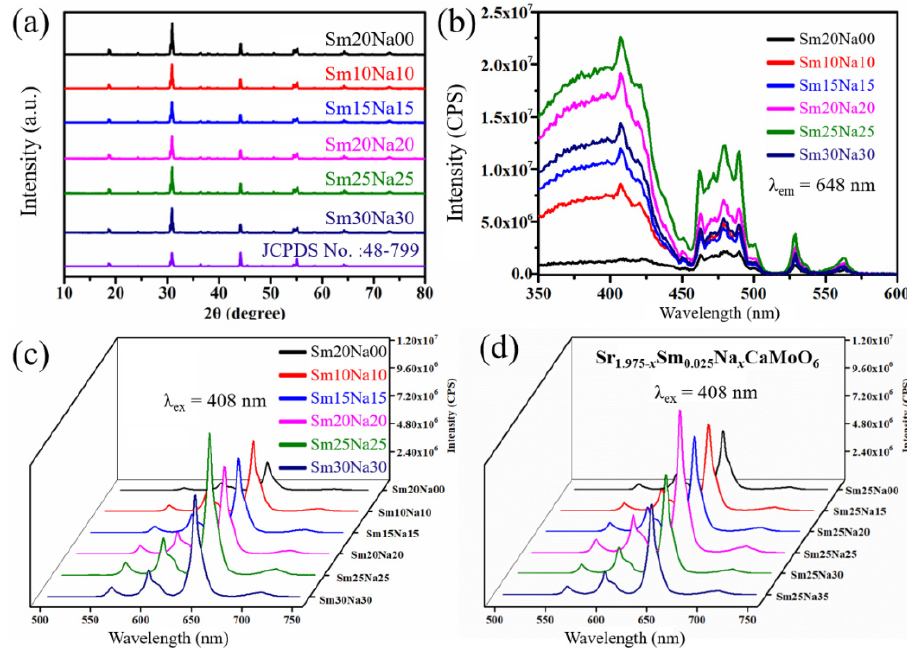
Figure 1. ( a ) XRD patterns of the Sr 2 CaMoO 6 :Sm,Na (Sm20Na00 − Sm30Na30). ( b ) Excitation spectra ( λ em = 648 nm) of the Sr 2 CaMoO 6 :Sm,Na samples. ( c ) Fluorescence emission spectra of Sr 2 CaMoO 6 :Sm,Na samples ( λ ex = 408 nm). ( d ) Fluorescence emission spectra of Sr 1.975- x CaMoO 6 :0.025Sm, x Na series samples. ( λ em stands for the emission wavelength and λ ex stands for the excitation wavelength.).